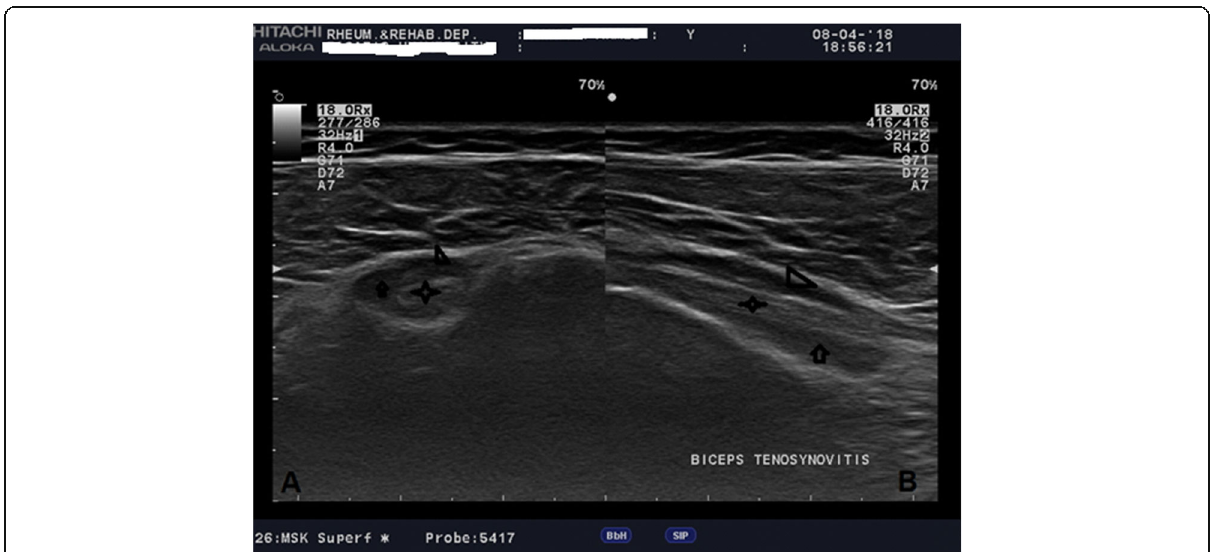
Fig. 3 Right biceptal tenosynovitis. a Longitudinal view. b Transverse view of the right long head of biceps tendon of the right shoulder joint. Asterisks showed the tendon fibers, arrows showed synovial hypertrophy, and arrow heads showed effusion around the tendon inside its synovial sheath